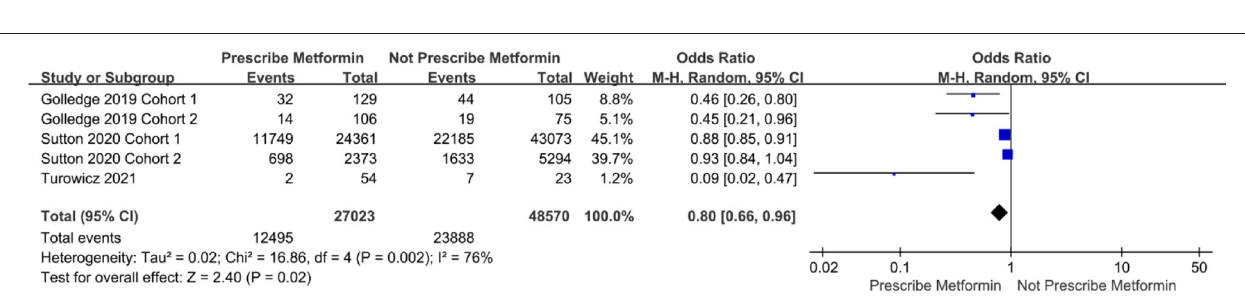
FIGURE 3 | Forest plot after excluding the data on the enlargement of abdominal aortic diameter by Fujimura et al.